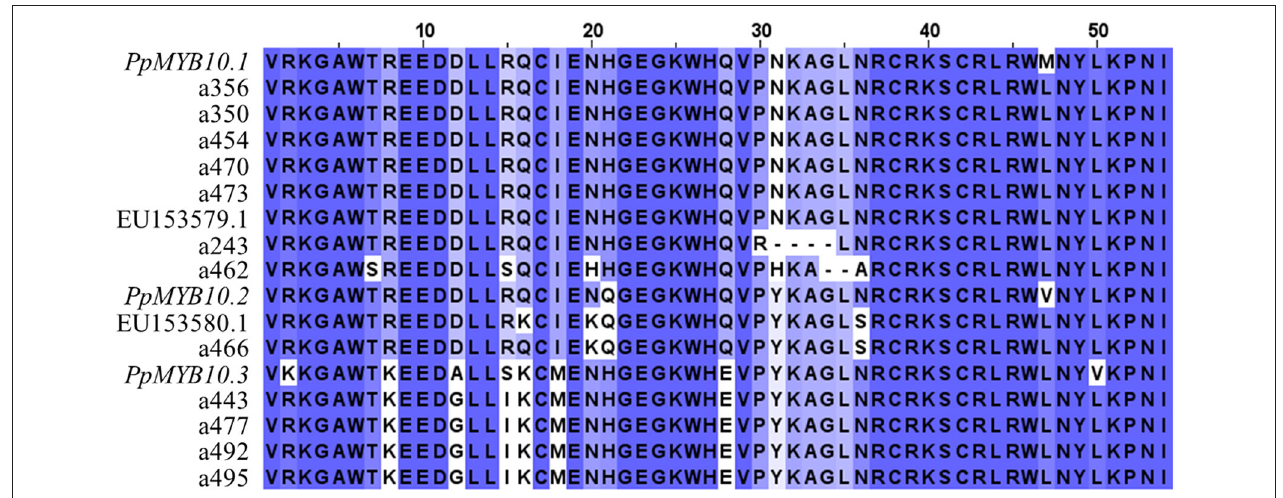
FIGURE 2 | Deduced amino acid sequence of the cloned alleles (a243 to a495) compared to the peach PpMYB10, Prunus domestica subsp. insititia (EU153579.1) and P. domestica (EU153580.1) R2R3-MYB10 translated sequence.